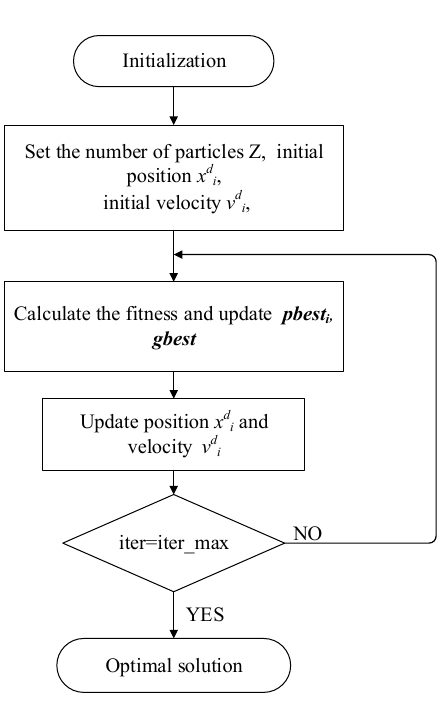
Figure 4. The flow chart of particle swarm optimization (PSO)